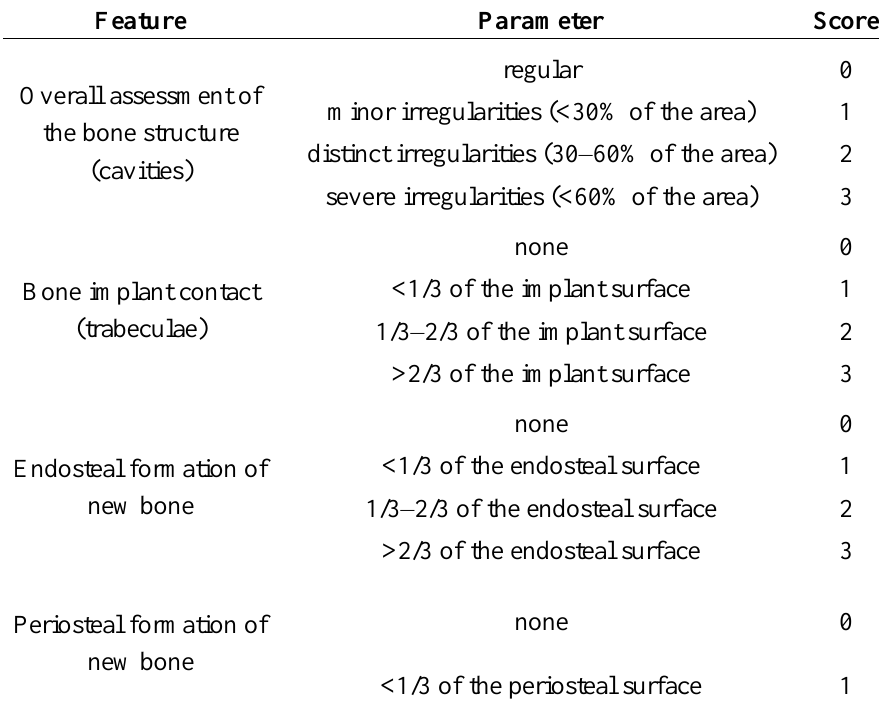
Table 6. Semiquantitative score for the osseous reaction to the implant in µCT 2D images of the